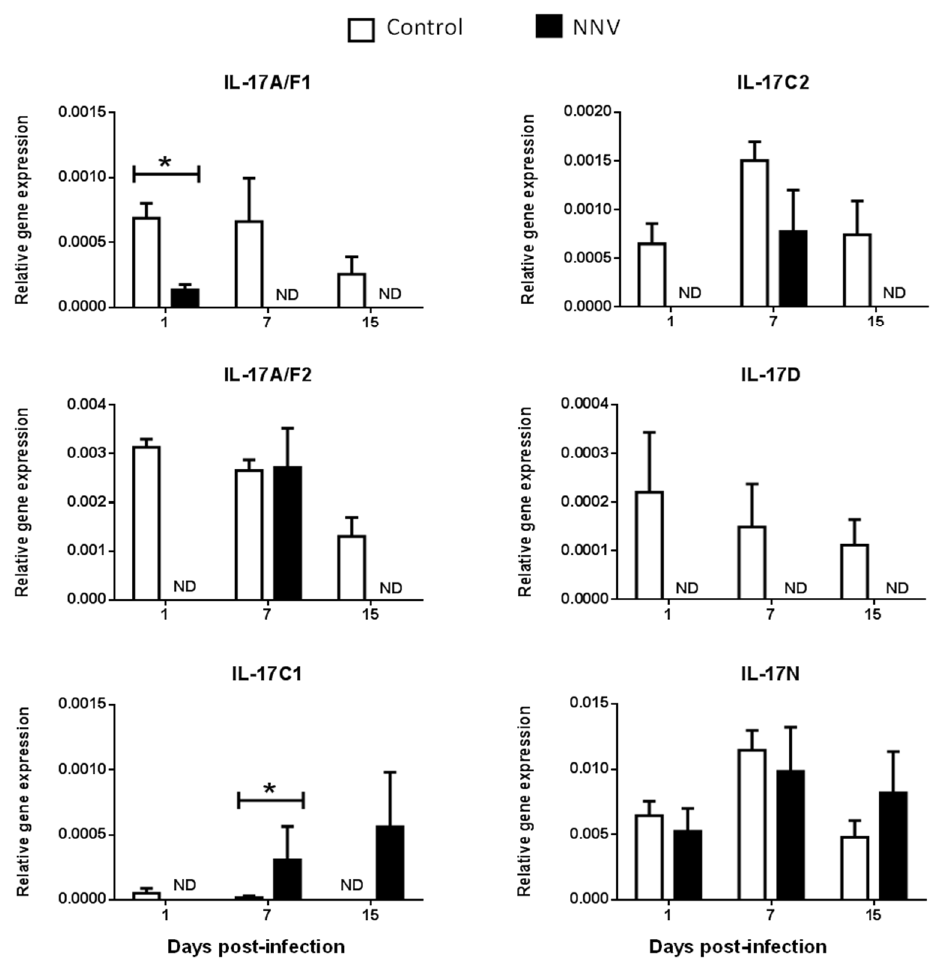
Figure 4. Nodavirus regulates the transcription of European sea bass IL-17 genes in the head-kidney . The relative gene expression of IL-17 ligands in the head-kidney of European sea bass specimens intramuscularly injected with 100 µ L of culture medium alone (control) or containing 10 6 TCID 50 of nodavirus (NNV) / fish. The data are presented as the mean ( n = 4–6) ± SEM relative to the expression of the endogenous controls. Asterisks denote significant di ff erences with the control group at each sampling time ( Student-t -test, p < 0.05). ND,